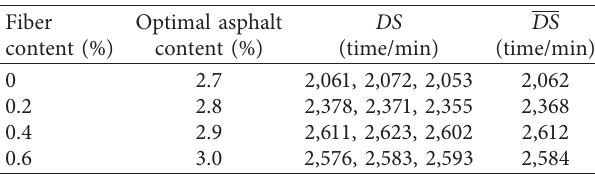
Figure 6: Relationship between compressive resilient modulus and fiber content. Table 9: Rutting test results on microbond asphalt macadam specimens with different basalt fiber contents.